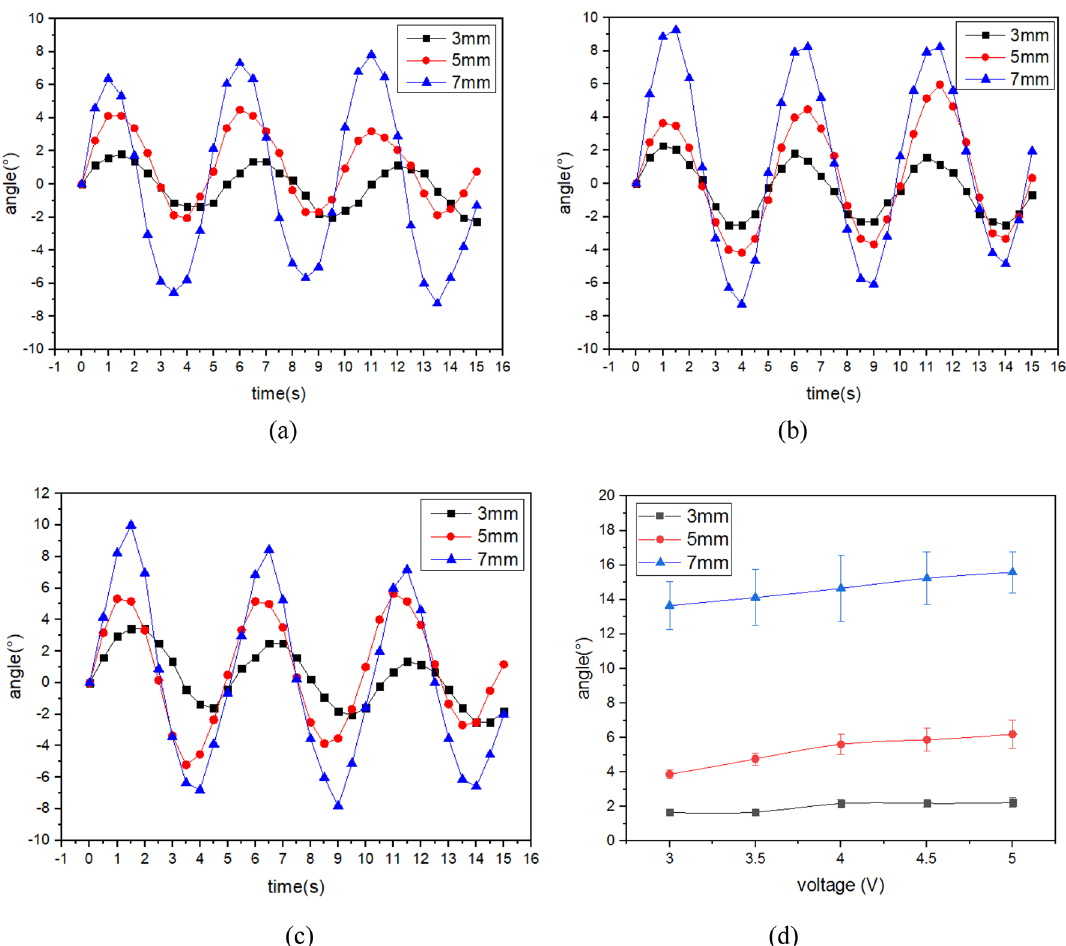
Figure 5. The twist angle of IPMC with patterned electrodes under 0.2 Hz AC Voltage. ( a ) 3v, ( b ) 4v, ( c ) 5v, ( d ) peak-valley angle under different